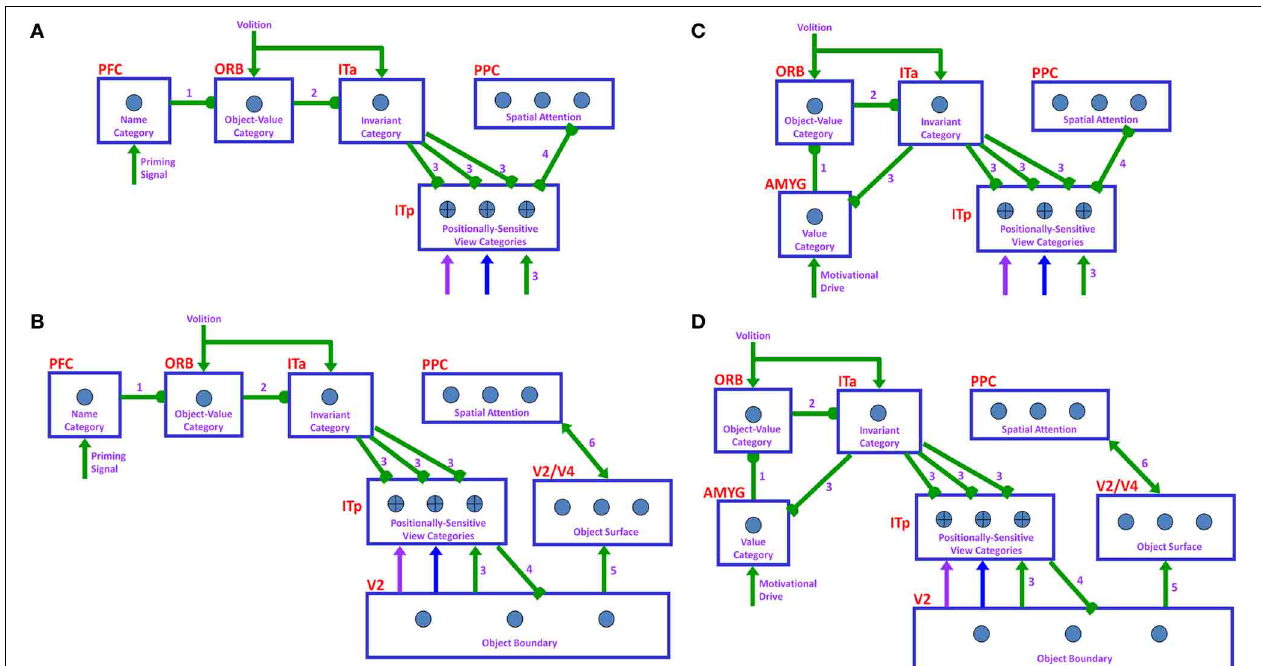
FIGURE 6 | Top-down name-driven What stream recognition to Where stream search and action through (A) a direct What-to-Where pathway and (B) an indirect What-to-Where pathway. Top-down value-driven What